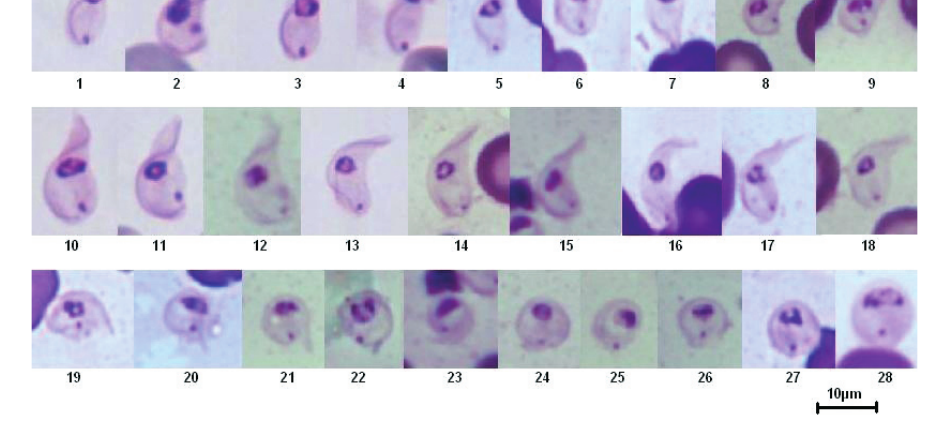
Fig. 14. – Tentative serial “S- shape” transformation of the T. (Nannomonas) hyperpachy- morph to the sphaeromorph (“tent folding” model). Photo by Marc